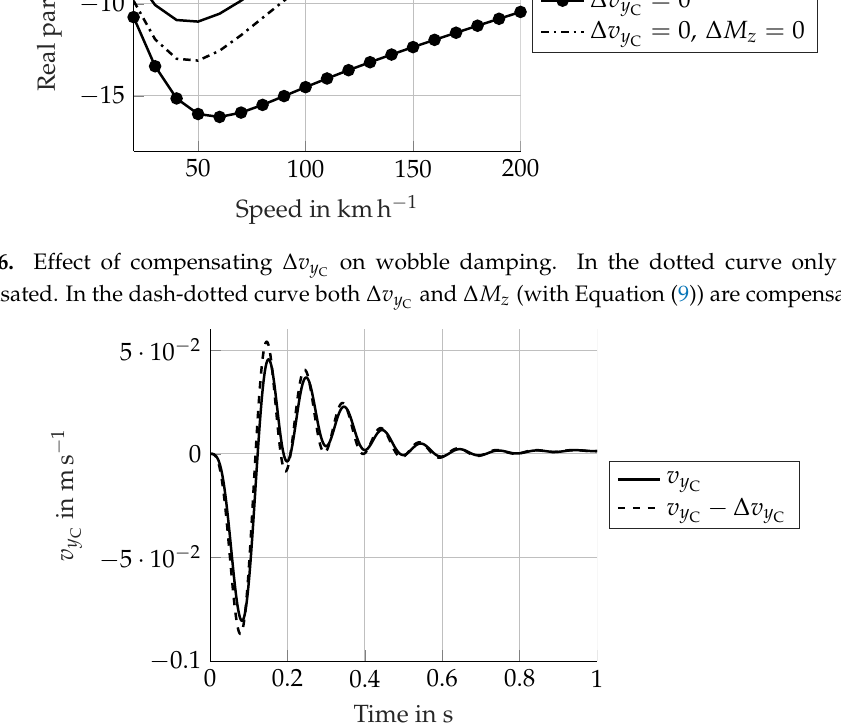
Figure 7. Variation of the lateral velocity of the contact point v y Time simulation at 50kmh − 1 and with a steer torque impulse as